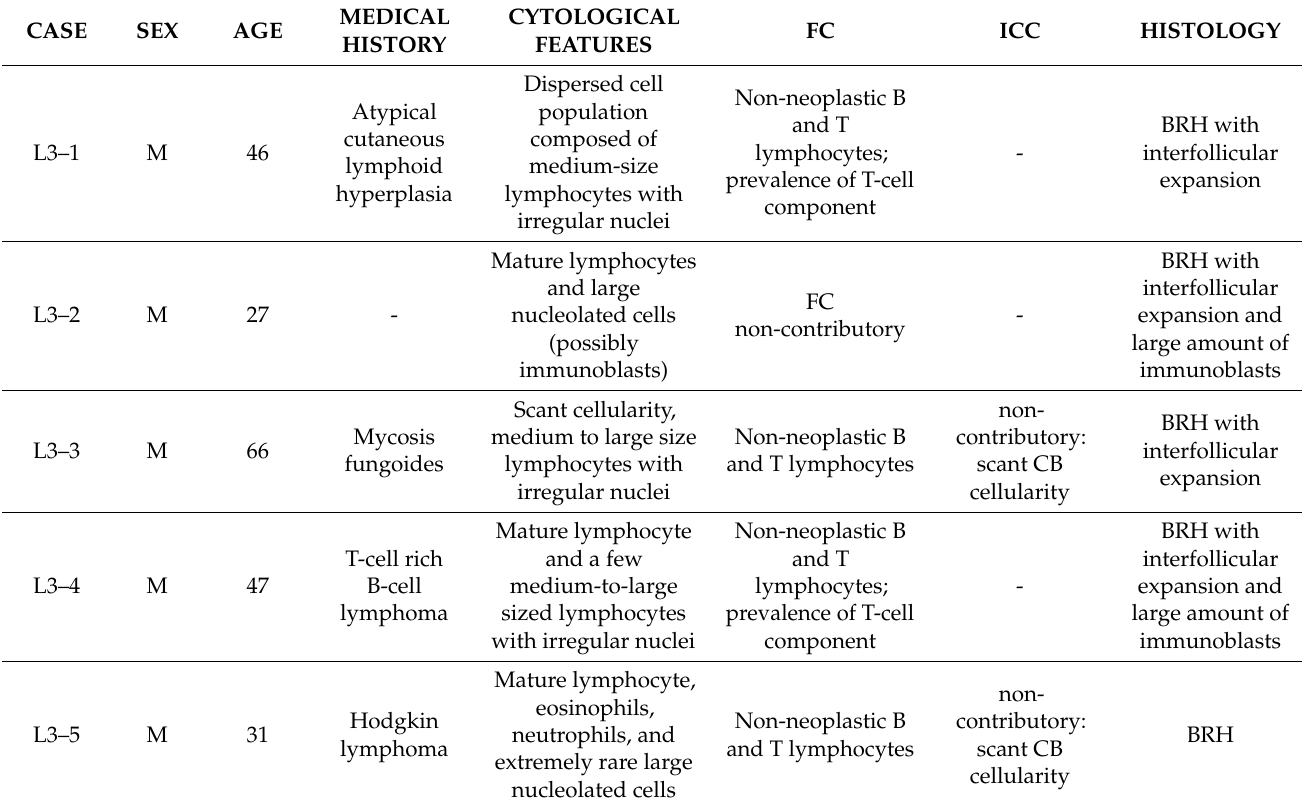
Table 6. Sample characteristics, clinical data, and diagnoses of false positive cases in the present series.